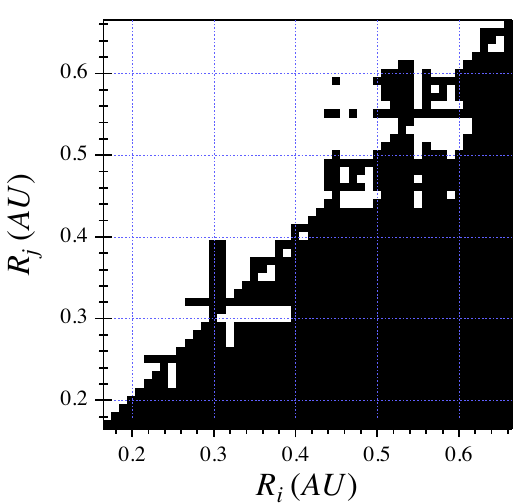
Figure 7. The disorder matrix D . Here, black color refers to D ij = 0 and white color to D ij =